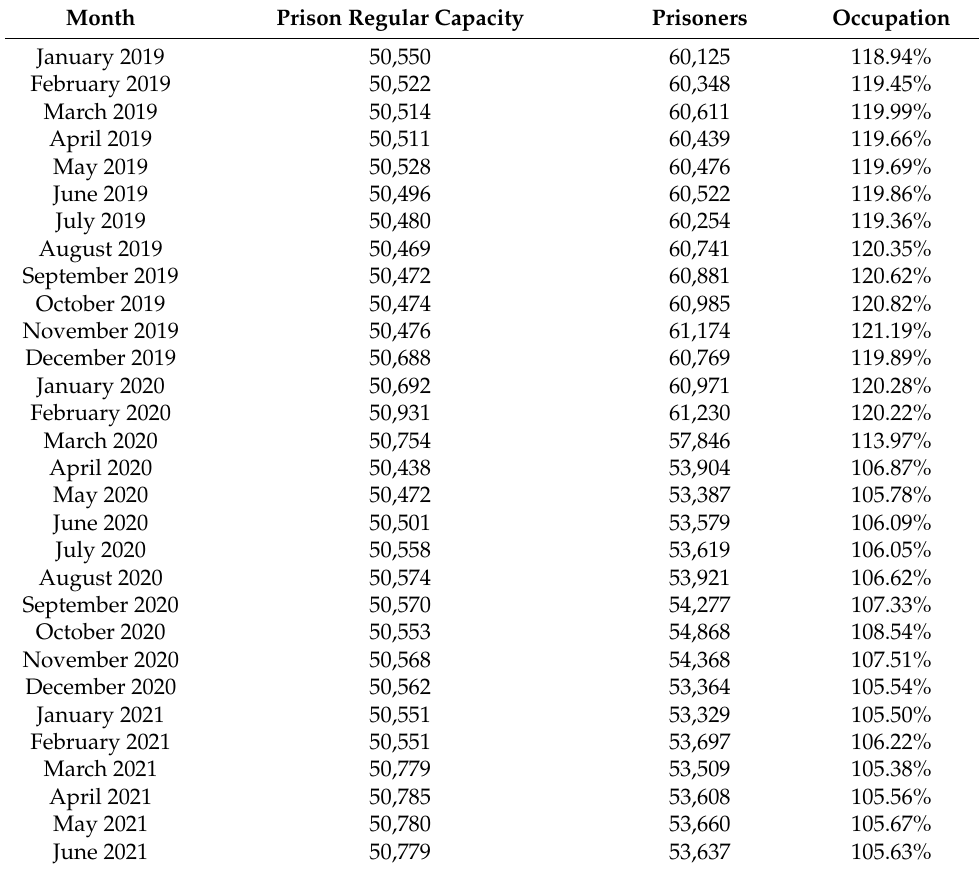
Table 1. Prisons’ occupation from January 2019 to June